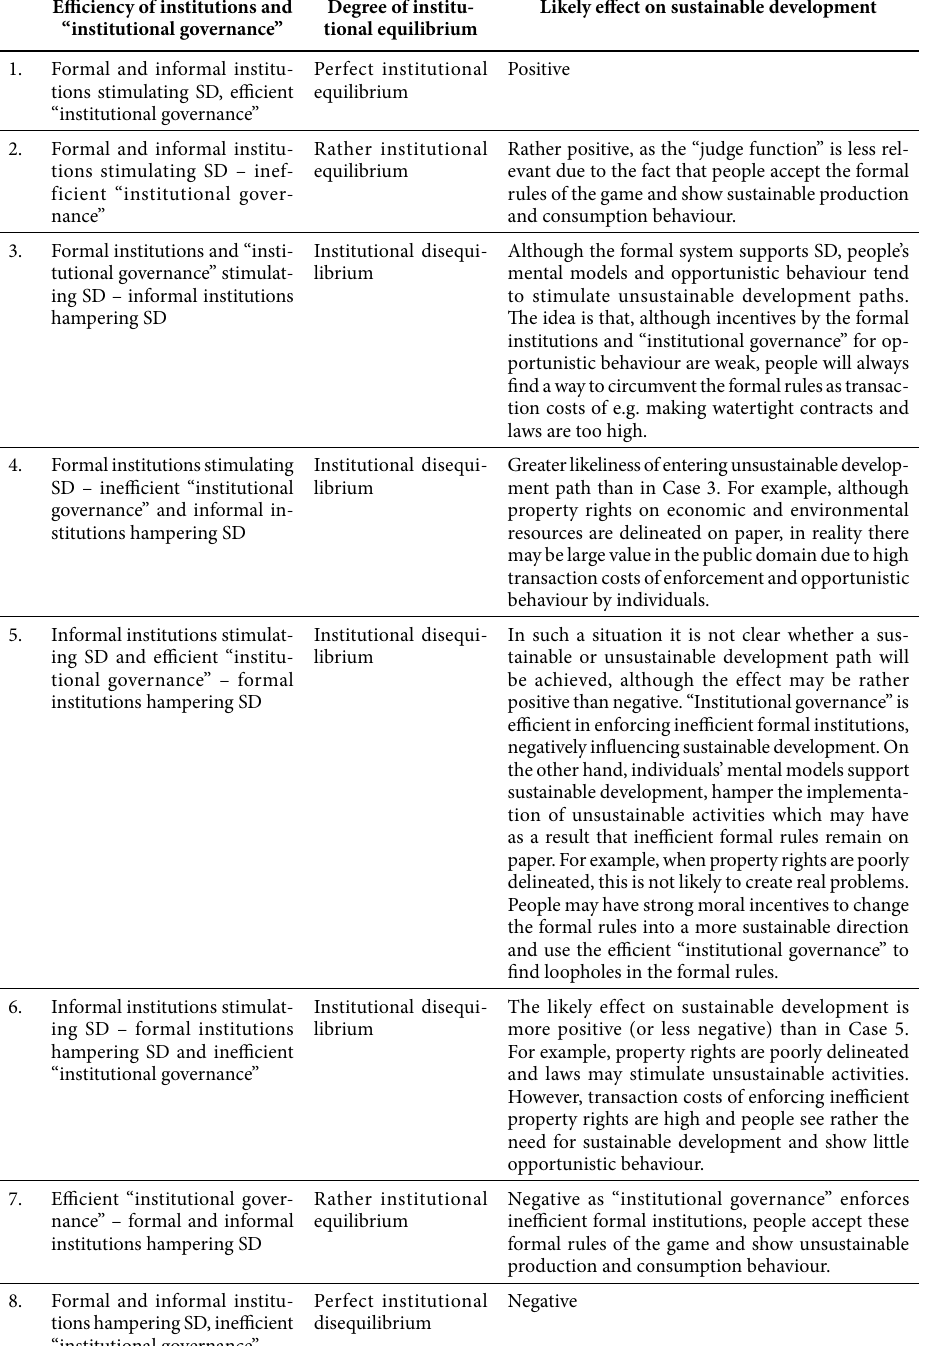
Table 1. Different degrees of institutional equilibrium and sustainable development